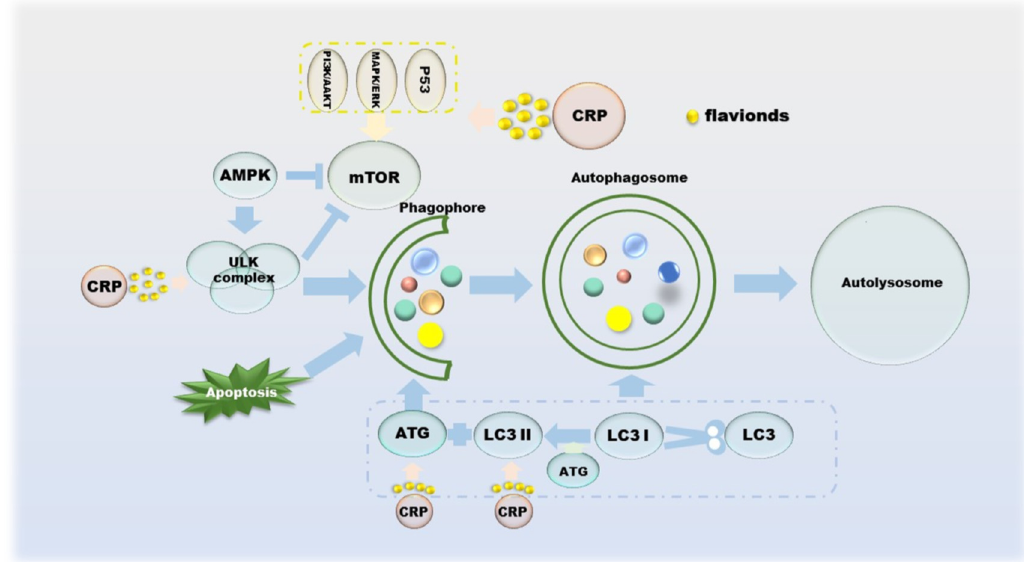
Figure 5. The role of CRP in the process of autophagy in cancer cells. Cancer metastasis is the spread of cancer cells to distant organs, and the invasion– migration of cancer cells during this process is controlled by multiple factors. The process of cell invasion–migration consists of the following aspects: (a) local invasion and cell migration of the basement membrane; (b) intravascular deep vasculature and/or lymphatic system; (c) survival in the circulation; (d) arrest and extravasation at distant organ sites;